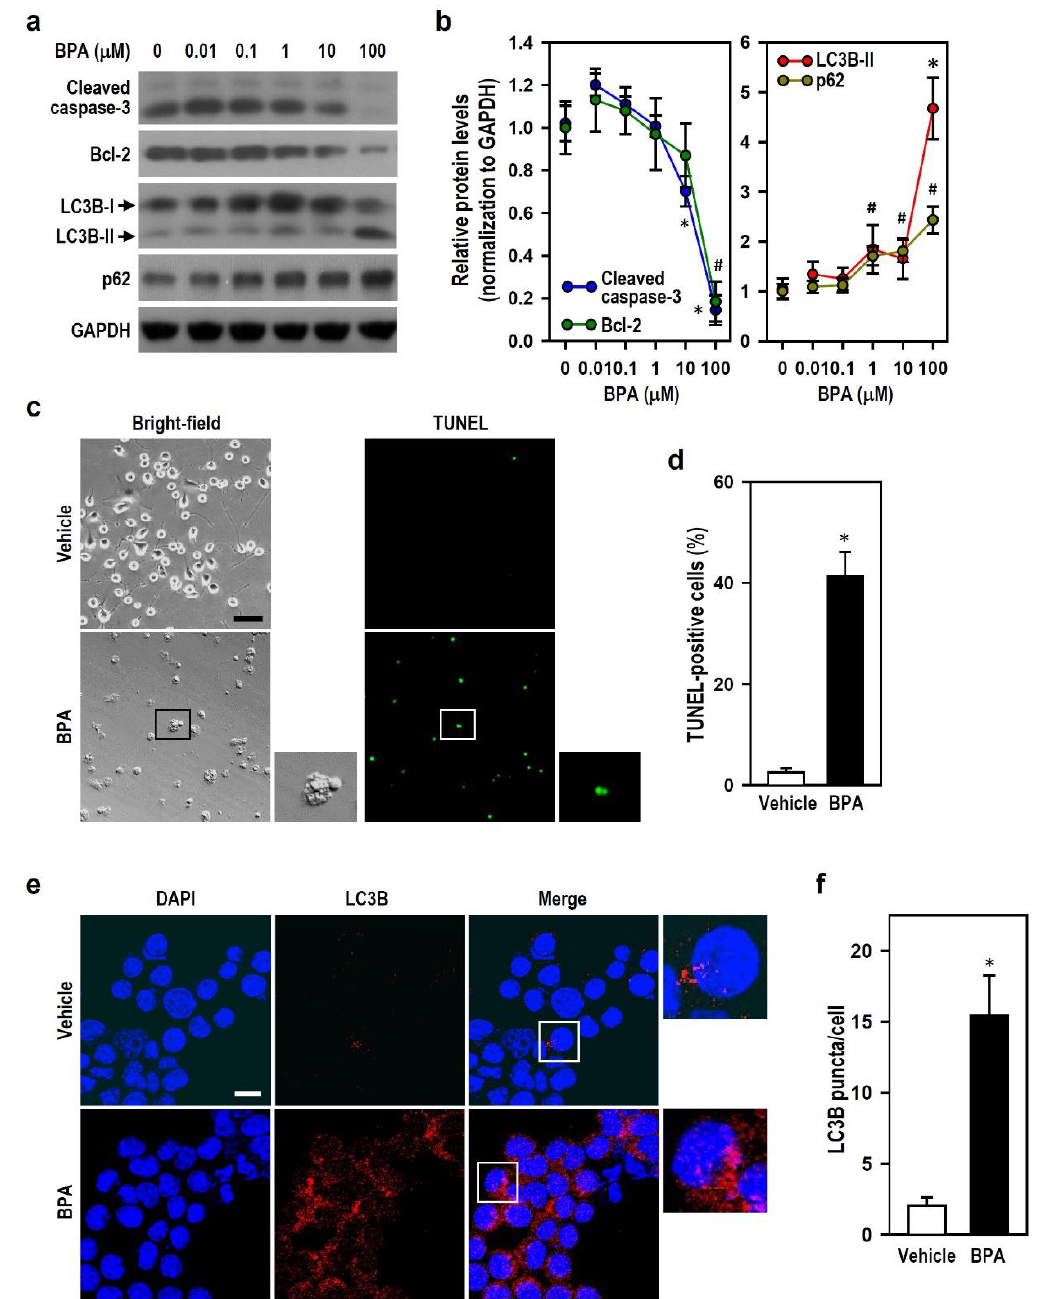
Figure 2. BPA interferes with autophagy and caspase-3-mediated apoptosis in N2a cells. ( a , b ) Cultures were treated with various BPA concentrations for 24 h. The levels of light chain 3B (LC3B), p62, cleaved caspase-3, and Bcl-2 were analyzed by Western blots. The line plots show the relative protein levels compared to untreated control group (0 μM BPA; assigned a value of 1). Each point represents the mean ± SEM ( n = 4). * p < 0.05 vs. untreated group in cleaved caspase-3 or LC3B-II plot. # p < 0.05 vs. untreated group in Bcl-2 or p62 plot. ( c , d ) Terminal deoxynucleotidyl transferase-mediated dUTP nick end labelling (TUNEL) assay was performed 24 h after vehicle or 100 μM BPA treatment in cultures. Representative photos show the matching bright-field and TUNEL-FITC fluorescence (scale bar = 50 μm). For clarity, a selective area with higher magnification is displayed on the side. A bar plot shows the relative quantitation data expressed as the percentage of TUNEL-positive cells (green fluorescence). Values are represented as mean ± SEM ( n = 3). * p < 0.05 vs. vehicle group. ( e , f ) Representative fluorescence images of LC3B staining are shown (scale bar = 20 μm). Cells grown on coverslips were harvested 24 h after vehicle or 100 μM BPA treatment. Immunostaining was executed using an antibody against LC3B (red), and the nucleus (blue) is marked by 4’,6-diamidino-2-phenylindole (DAPI). The side insert at higher magnification shows the pattern of LC3 puncta. A bar plot shows the relative quantitation results of LC3B immunoreactivity in cultures. Data are represented as mean SEM ( n = 3). * p < 0.05 vs. vehicle group.